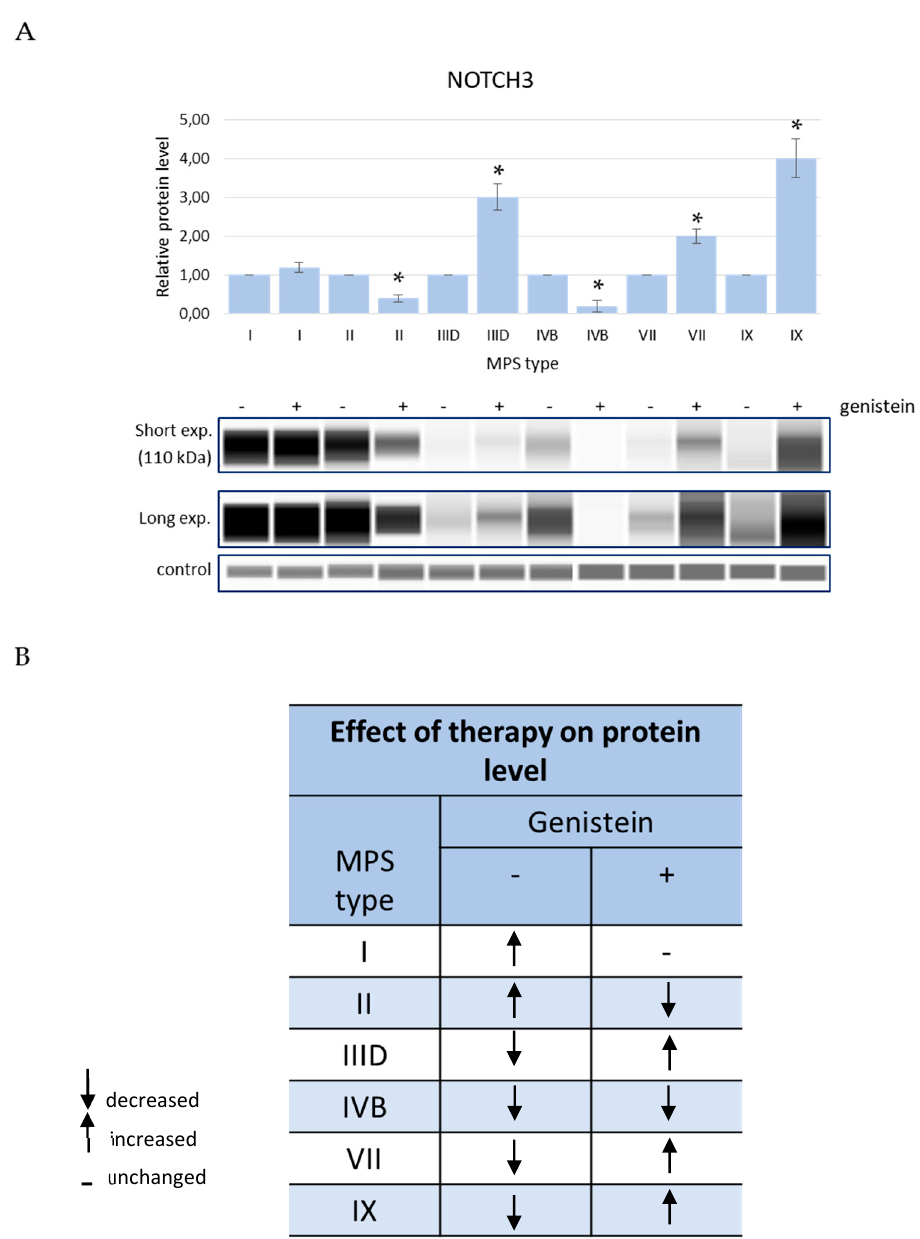
Figure 8. Levels of the NOTCH3 protein in fibroblasts of different types of MPS with (+) and without ( − ) treatment with 50 µ M genistein for 48 h (only MPS types which revealed significantly changed amounts of this protein relative to HDFa control cells (see Figure 4) are shown). Panel ( A ) shows representative blots and the quantification of the results by densitometry, where value 1 corresponds to the level of NOTCH3 determined in MPS cells not treated with genistein. Panel ( B ) shows the scheme of results where the column ( − ) indicates the levels of NOTCH3 in MPS cells relative to HDFa control while the column (+) indicates the levels of this protein in cells of the corresponding MPS types after 48 h of treatment with 50 μ M genistein relative to untreated MPS cells. Up-headed arrows indicate increased levels, down-headed arrows indicate decreased levels, and dashes indicate no significant changes. In panel ( A ), the results indicated by the columns are mean values from three independent experiments with error bars representing SD. Statistically significant differences relative to the untreated MPS cells ( p < 0.05) are indicated by asterisks (*). Levels of EXOSC9 decreased in MPS cells relative to HDFa controls while treatment with genistein, in order to reduce GAG levels, resulted in an improvement of this parameter in MPS I and MPS IIID while it remained at the level similar to (without statistically